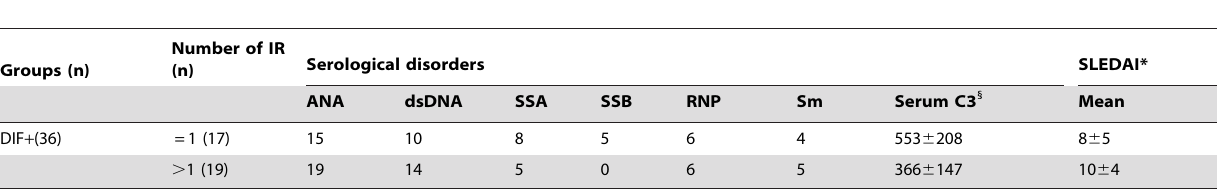
Abbreviations: IR, immunoreactant. 1 P , 0.05: Immunoreatants ( . 1) versus immunoreactant (=1); P , 0.01: Immunoreatants ( . 1) versus DIF 2 . *P , 0.05: Immunoreactant ( . 1) versus DIF 2